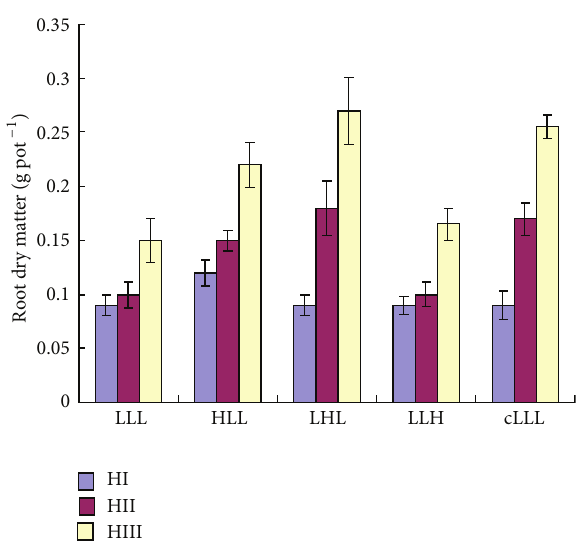
Figure 2: Effects of exogenous Ca supply during, before and after 100 𝜇 M Al treatment on root growth in wheat plants. Three letters either L and/or H indicate three weeks and Ca level (L = 250 𝜇 M, H = 2500 𝜇 M). C stands for control. Values are the means ± SE of three replicates.